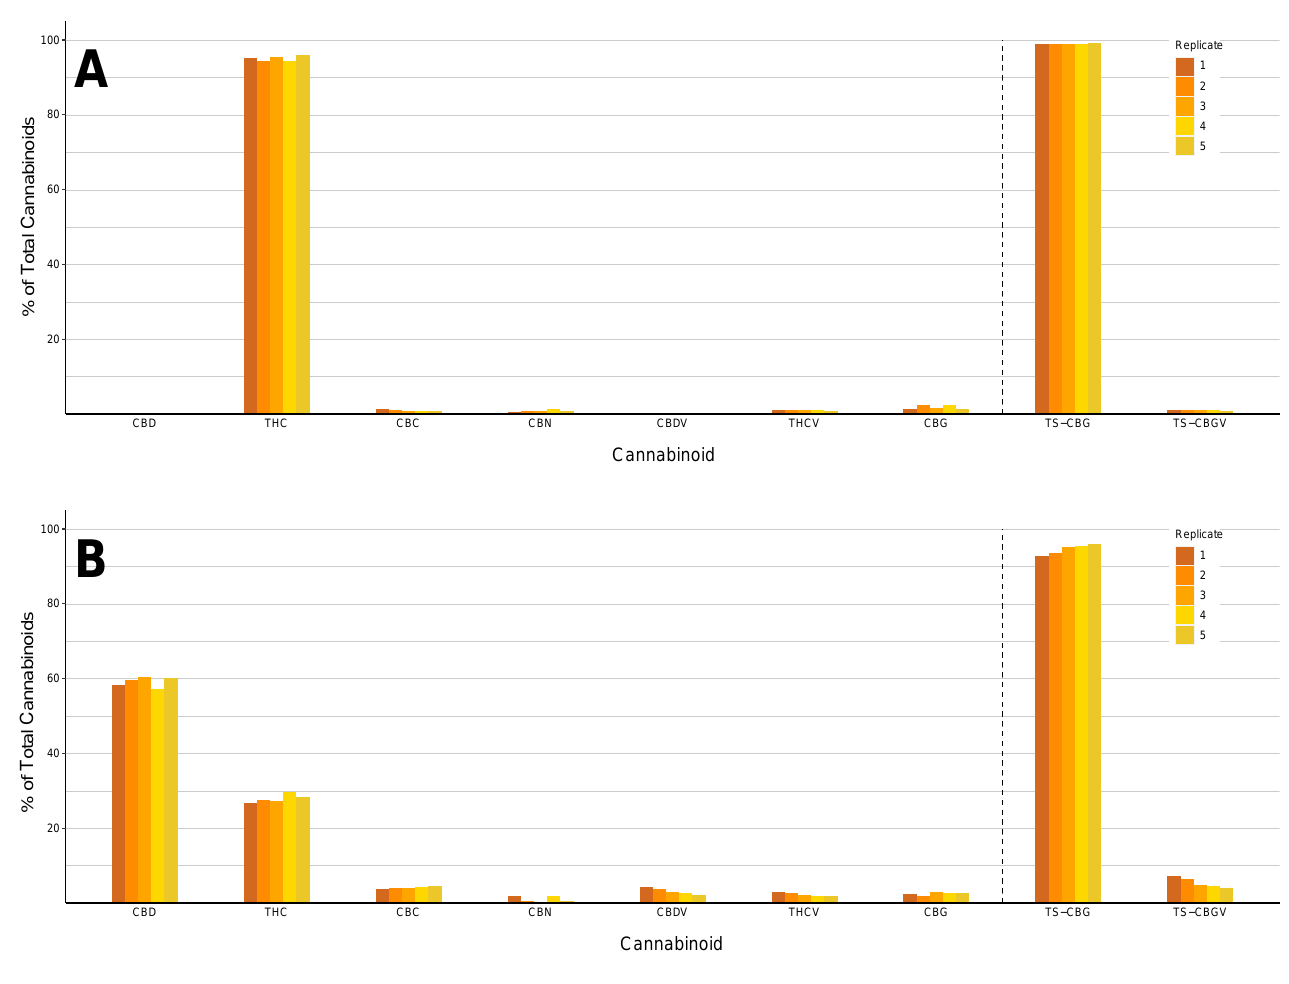
Figure 6. Variations in cannabinoid ratios (% of total cannabinoids) across 5 clonal plant replications. ( A ) High-THC genotype, ( B ) blended THC:CBD genotype. Experimental replicates are indicated by shades of